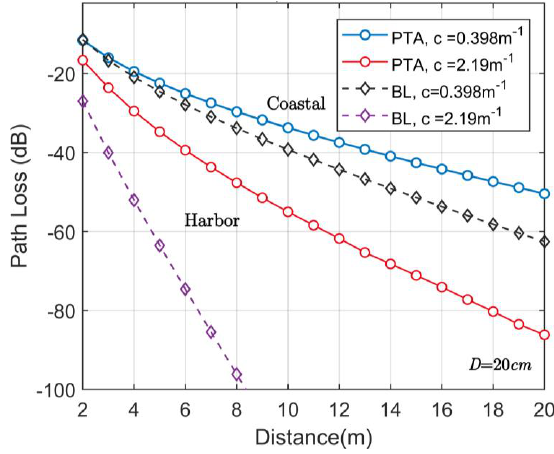
Figure 8. Path loss derived by the BL-analytical method and PTA simulation.